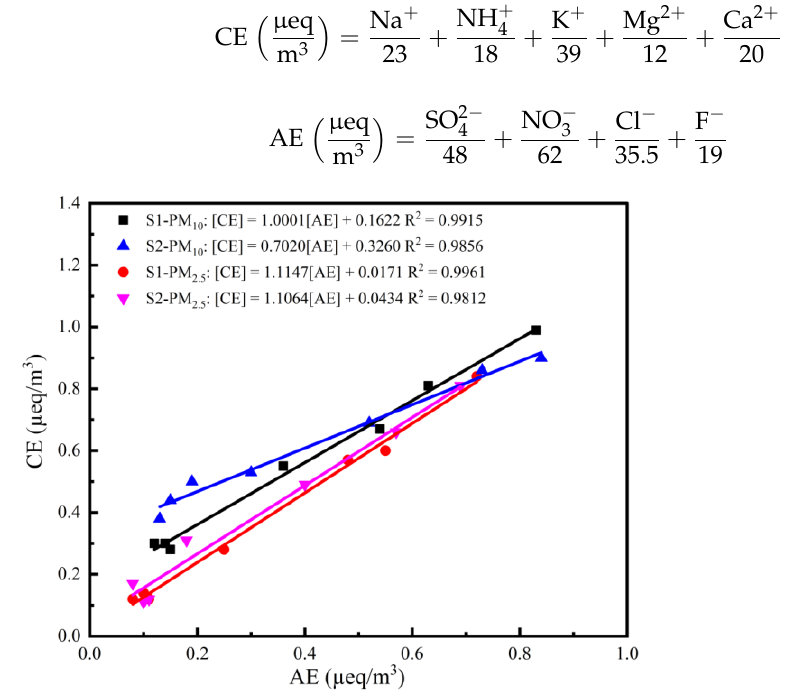
Figure 5. Relationship between AE and CE in PM.